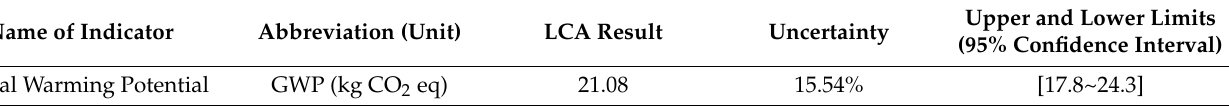
Table 4. Carbon footprint results and uncertainties.